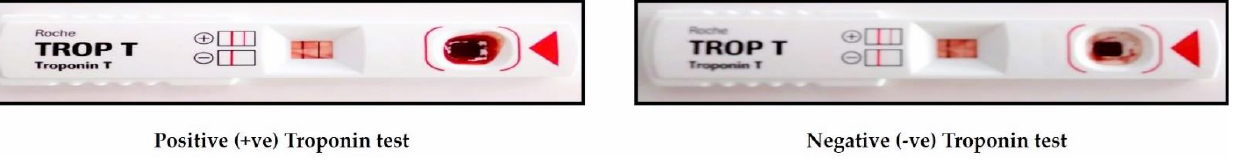
Figure 8. Troponin-T Test.